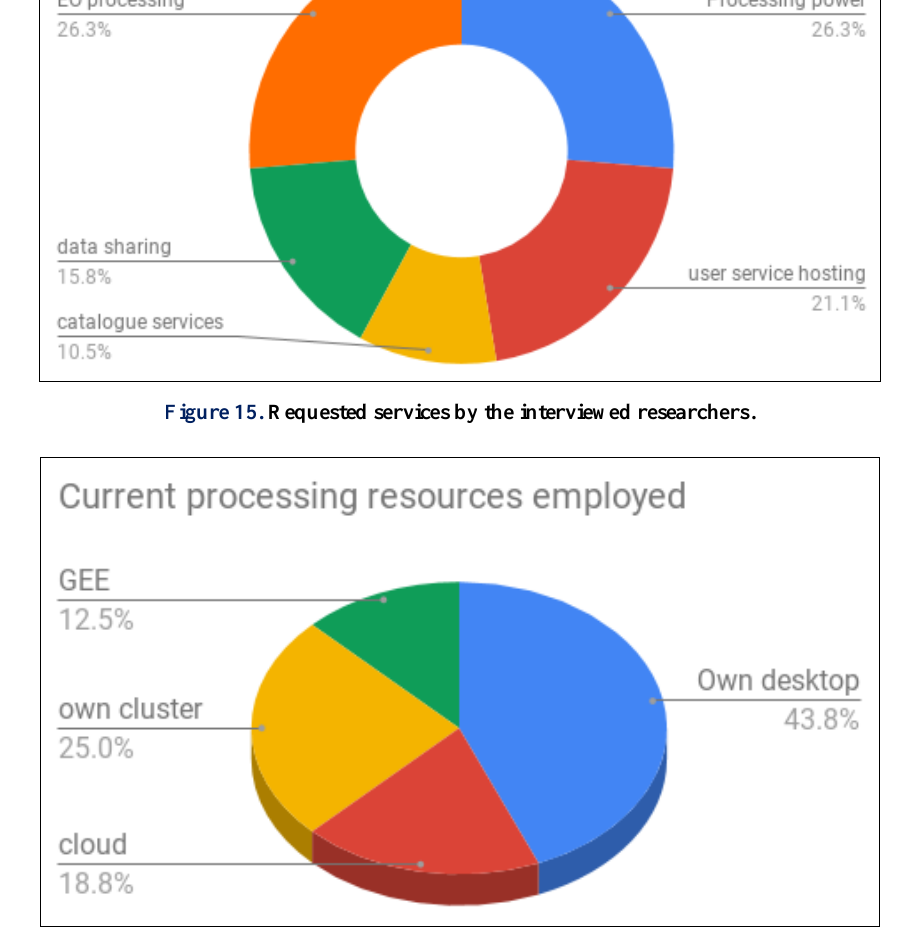
Figure 16. Current processing resources employed by the interviewed